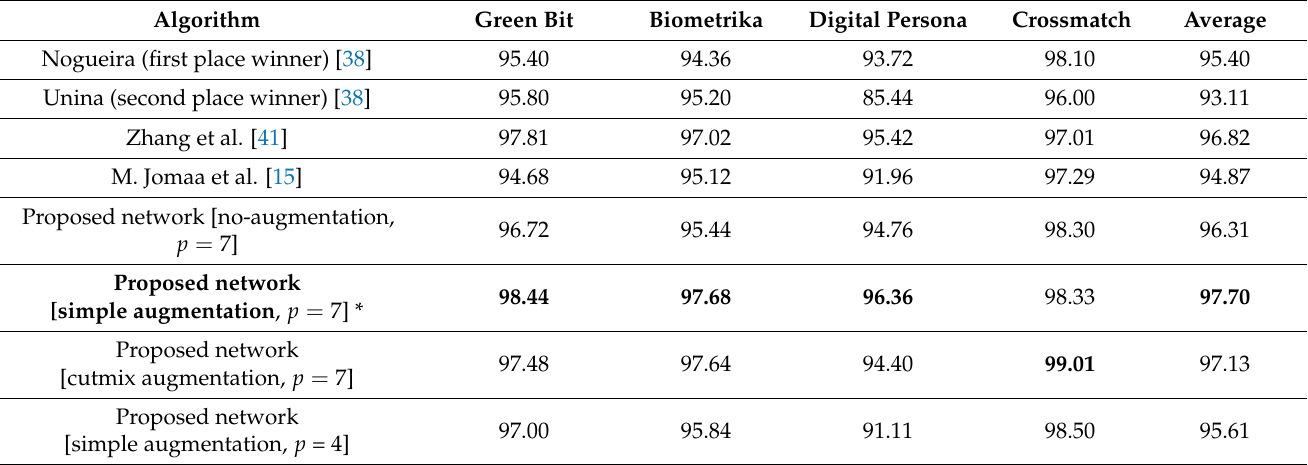
Table 3. Comparison between the results of the proposed network and the state-of-the-art approaches on LivDet 2015 dataset in terms of classification accuracy (acc